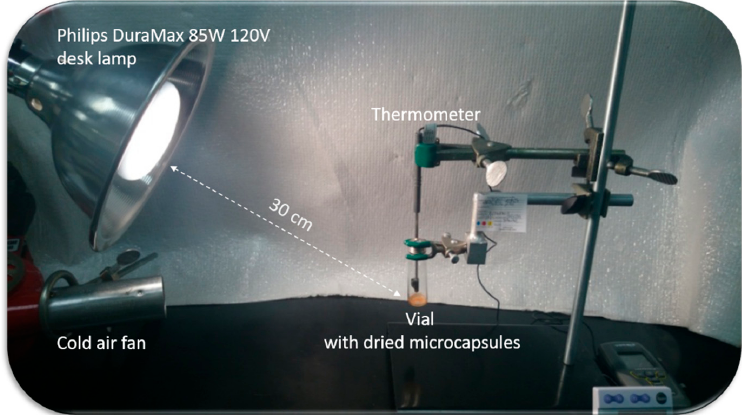
Figure 2. Release experiment setup.